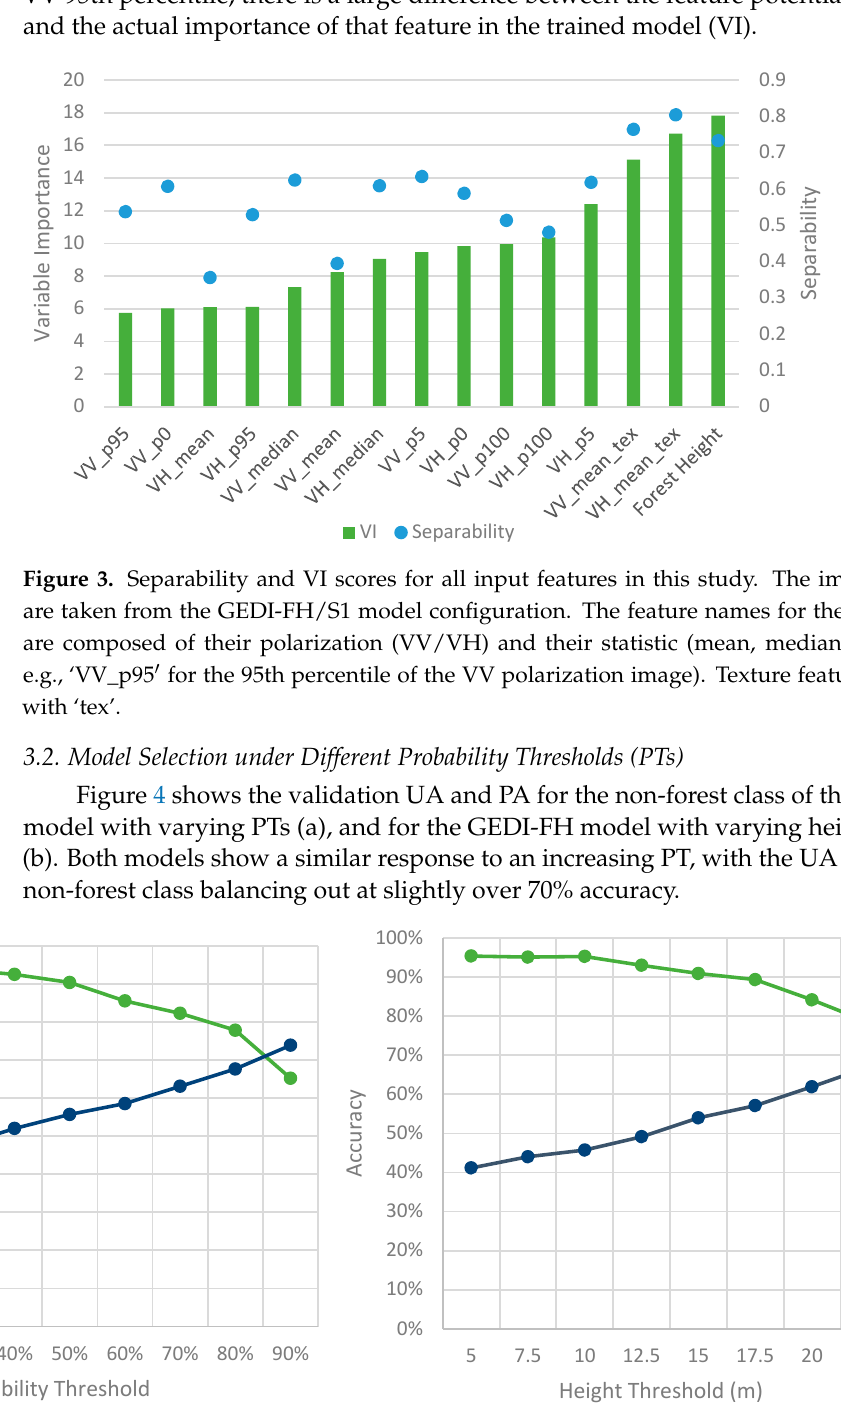
VV-95th percentile, there is a large difference between the feature potential (Separability)